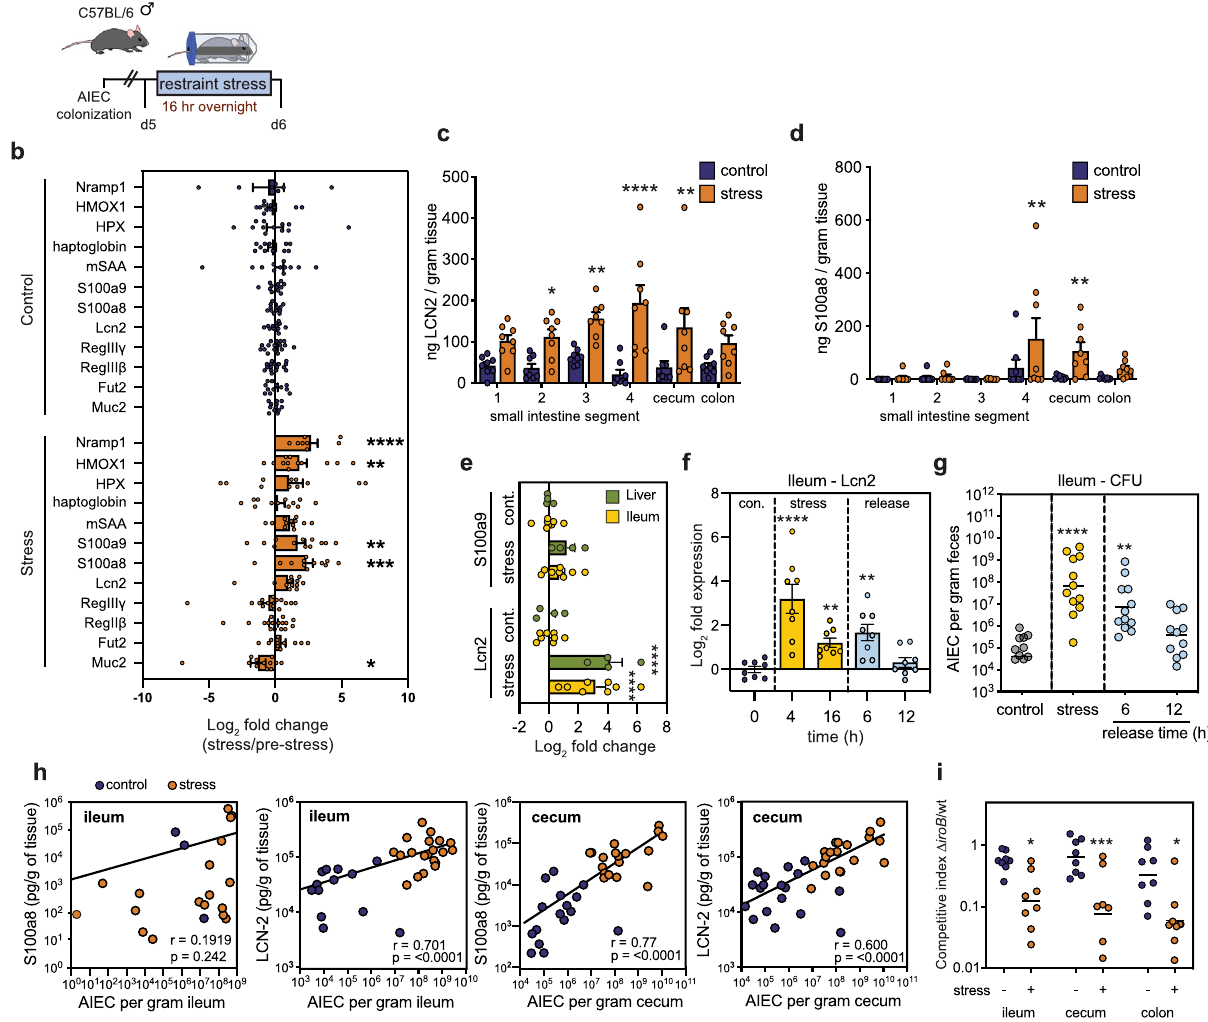
Fig. 4 Stress-induces nutritional immunity within the gut provides a competitive advantage to AIEC. a Schematic representation of infection and stress protocol. b RT-qPCR analysis from ileal samples of AIEC-colonized starved ( n = 12 – 16) or stressed ( n = 12 – 16) mice. Signi fi cance was determined by two- way ANOVA, not corrected for multiple comparisons ( n = Muc2 (c-12, s-12); Fut2 (c-12, s-12); Reg3 β (c-16, s-16); Reg3 γ (c-16, s-16); Lcn2 (c-12, s-12); S100a8 (c-12, s-12); S100a9 (c-12, s-12); mSAA (c-12, s-12); haptoglobin (c-11, s12); HPX (c-12, s-11); HMOX1 (c-11. s-12); nRAMP1 (c-7, s-8)); Muc2 p = 0.0452; S100a8 p = 0.0003; S100a9 p = 0.0092; HMOX1 p = 0.0017; NRAMP1 p < 0.0001. c Quanti fi cation of Lcn2 by ELISA along the length of the intestinal tract in AIEC-colonized starved ( n = 8) and stressed ( n = 8) mice. The small intestine was divided into four 8 cm segments in which segment 4 was proximal to the cecum. Signi fi cance was determined by two-way ANOVA, not corrected for multiple comparisons, Seg 1 p = 0.0551; Seg 2 p = 0.0164; Seg 3 p = 0.0033; Seg 4 p < 0.0001; Cecum p = 0.0023; Colon p = 0.0754. d Quanti fi cation of the calprotectin subunit S100a8 along the length of the intestinal tract in AIEC-colonized starved ( n = 8) and stressed ( n = 8) mice. Signi fi cance was determined by two-way ANOVA, not corrected for multiple comparisons, Seg 4 p = 0.0042, Cecum p = 0.0088. e RT-qPCR analysis of S100a9 and Lcn2 RNA expression in the liver and ileum of AIEC-colonized mice following 4 h of starvation (ileum n = 8, liver n = 4) or stress (ileum n = 8, liver n = 4). Signi fi cance to control was determined by one-way ANOVA, not corrected for multiple comparisons, Lcn2 control:stress, ileum, p < 0.0001; Lcn2 control:stress, liver, p < 0.0001. f RT-qPCR analysis of Lcn2 in the ileum. Samples were collected from AIEC-colonized mice at baseline as a control, 4 and 16 h of overnight stress, and at 6 and 12 h following restraint release (for all time points n = 8). Signi fi cance to control was determined by one-way ANOVA, not corrected for multiple comparisons, 4 h p < 0.0001; 16 h, p = 0.0070; 6 h, p = 0.0017. g AIEC fecal burdens collected from mice at baseline as a control ( n = 11), 16 h of stress ( n = 12), and at 6 h ( n = 12) and 12 h ( n = 11) following restraint release and recovery. Signi fi cance to control was determined by one-way ANOVA, not corrected for multiple comparisons, stress, p < 0.0001; 6 h release, p = 0.0016. h A two-tailed Spearman correlation of either calprotectin subunit S100a8 concentration or Lcn2 concentration and AIEC fecal burdens in the ileum and cecum ( n = 40), ileum, p < 0.0001; cecum, p < 0.0001. i Competitive infection of wild-type AIEC and Δ iroB in starved ( n = 8) and stressed ( n = 8) mice. Mice were infected with a 1:1 ratio of wild type: Δ iroB and were subjected to overnight starvation or stress 2 days later. Following stress or starvation, ileum, cecum, and colon tissues were collected and the ratio of wild type: Δ iroB determined by selective plating. Signi fi cance was determined by a two-way ANOVA, not corrected for multiple comparisons, ileum, p = 0.0148; cecum, p = 0.0005; colon, p =